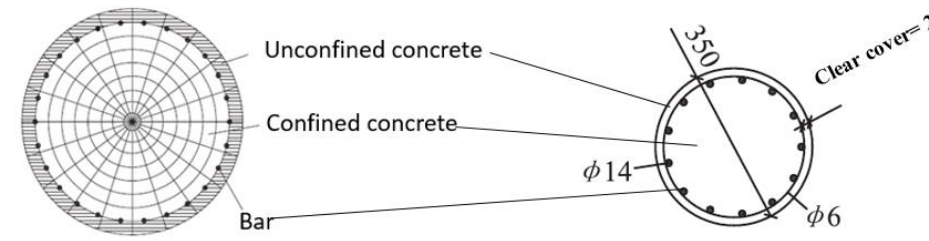
Figure 9. Fiber section defining the column cross-section. Table 2. Confined concrete material properties.